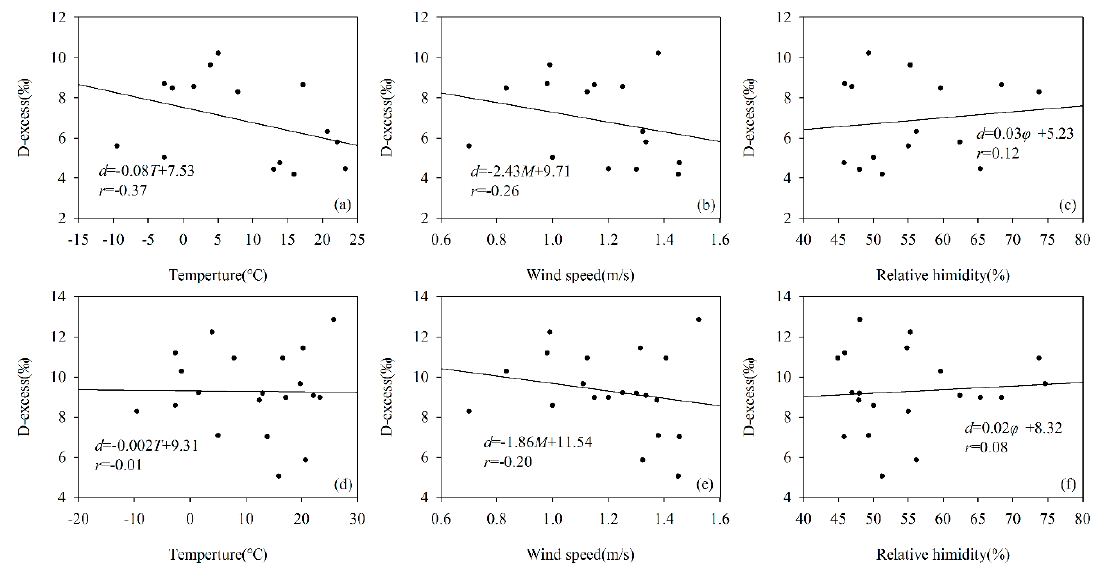
Figure 7. Correlation between meteorological parameters (surface air temperature, wind speed, and relative humidity) and D-excess in the lake ( a , b and c ) and the river water ( d , e and f ).